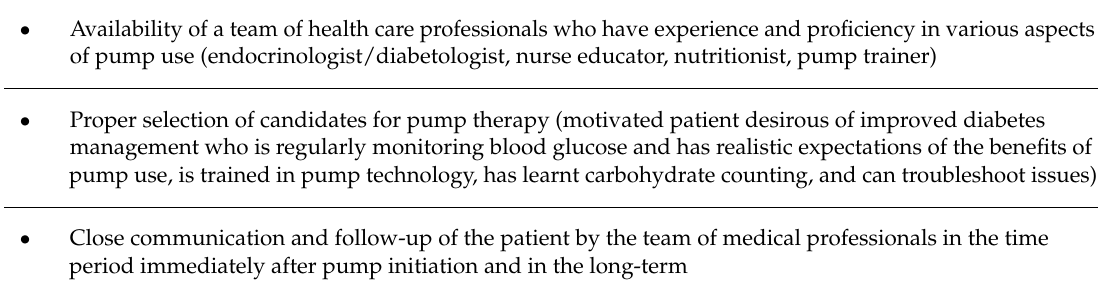
Table 3. Factors related to Successful Initiation and Maintenance of Insulin Pump